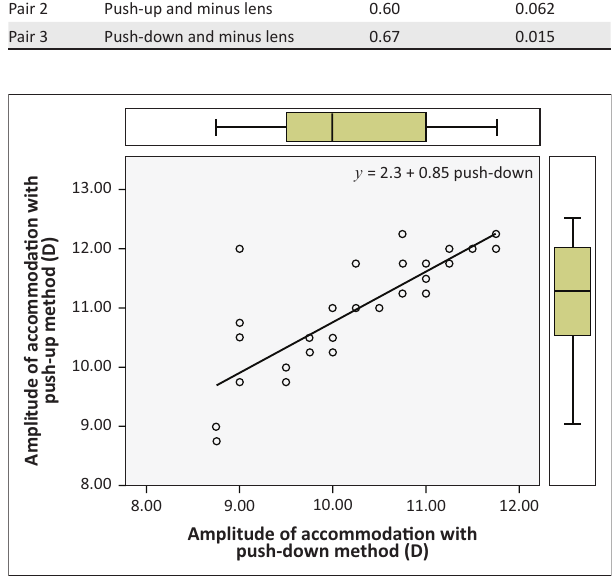
FIGURE 3: Correlation plot of the amplitude of accommodation measured with the push-up method to first sustained blur and the push-down method to just clear.